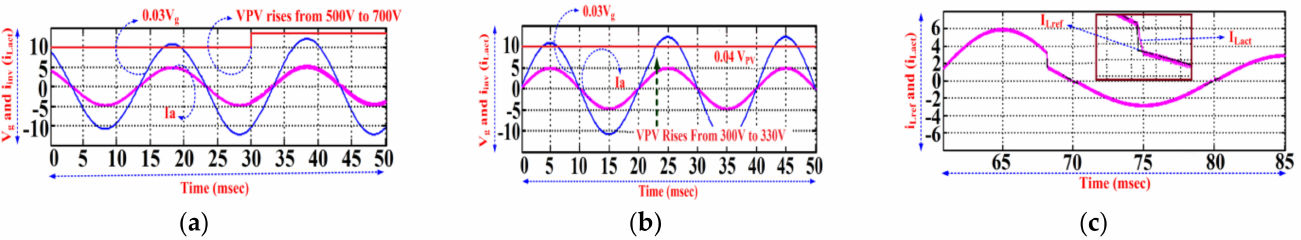
Figure 8. The performance of the PV-connected grid-connected inverter in different grid variations. ( a ) Change in PV voltage. ( b ) Change in grid voltage. ( c ) Grid current reference.